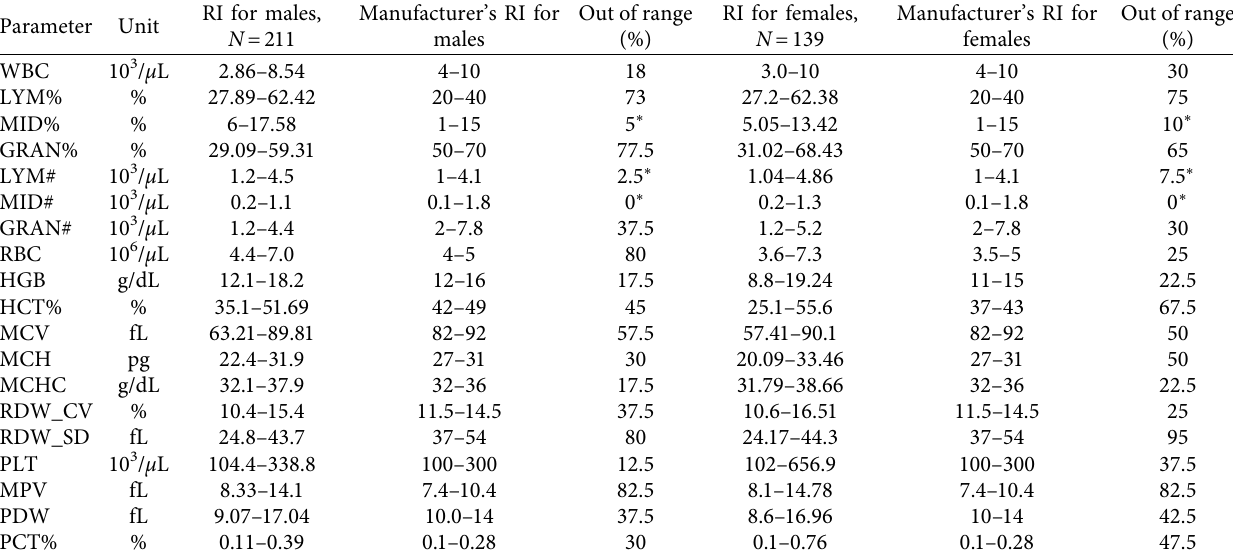
Table 2: Obtained reference intervals and manufacturer’s reference intervals of hematological parameters.